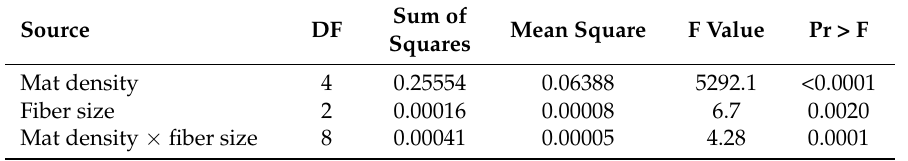
Table 3. Analysis of variance for thermal conductivity at different levels of mat density and fiber sizes.